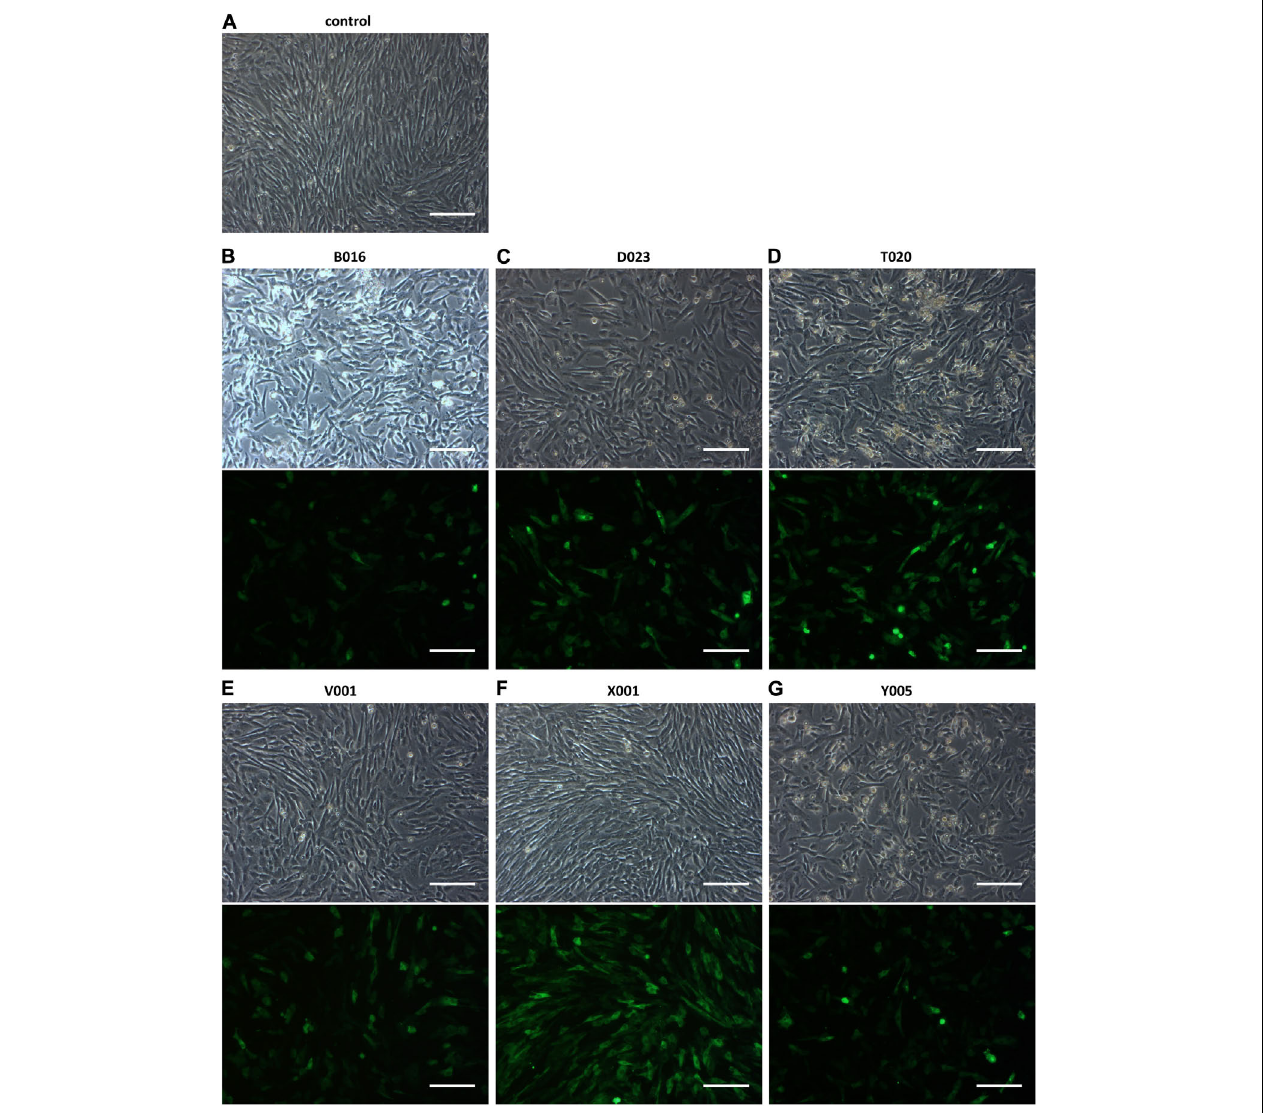
FIGURE 1 | Nucleofection optimization of CPCs with different programs. (A) Control figure shows nucleofected CPCs with no DNA. (B–G) GFP expression in CPCs as a result of different nucleofection programs. Upper rows show bright field images of nucleofected CPCs and lower rows show GFP expression. Images shown are representative examples of duplicate experiments. Scale bars represent 200 µ